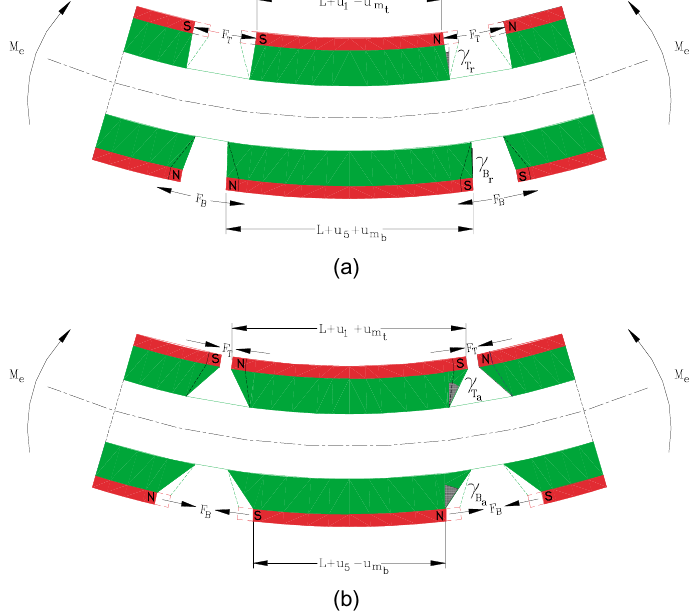
Fig. 2. Possible arrangements of the Magnetic Constrained Layer Damping (a) layers in repulsion and (b) layers in attraction. (PCLD – dashed lines and MCLD – solid lines). for the piezo-films, associated circuitry as well as any external energy sources